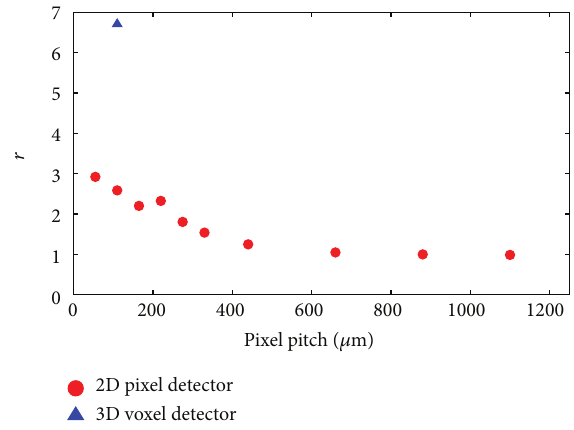
Figure 16: The effective background reduction factor 𝑟 as a function of pixel pitch after the classification working only in the sensor plane (red) for a 3mm thick CdTe sensor. Additionally, the effective background reduction factor 𝑟 obtained with 3D-track analysis at 110 𝜇 m pixel pitch is shown